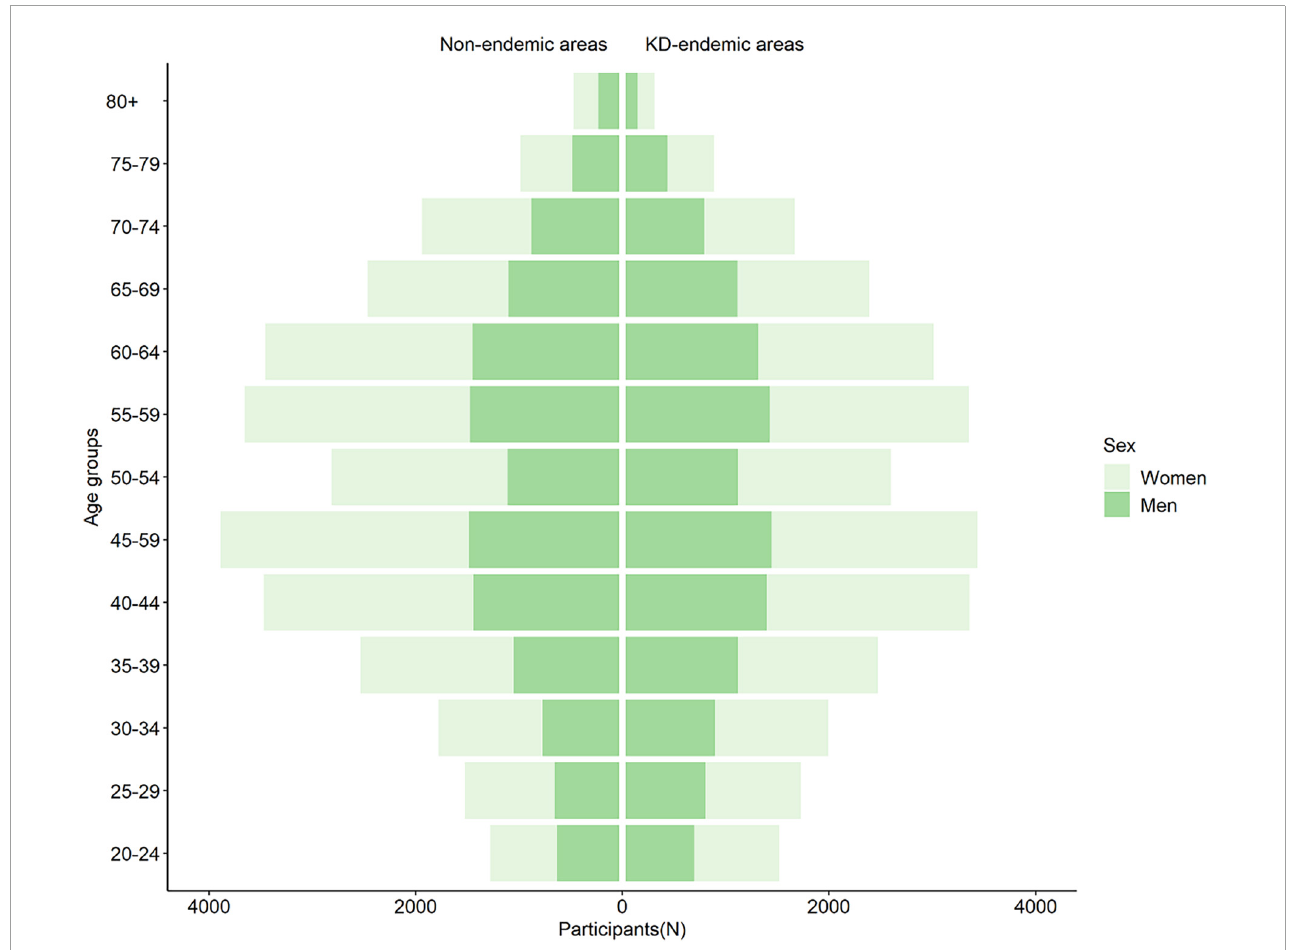
FIGURE1 Population pyramid of participants in KD-endemic and non-endemic areas. KD, Keshan disease; N, number.